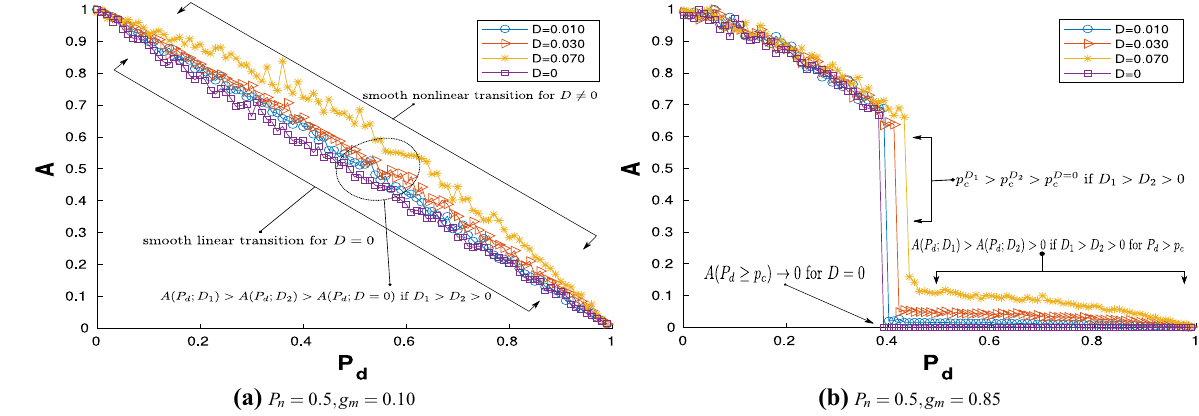
Figure 6. Variation of A with P d ; P n = 0.5 and D = 0.01, 0.03, 0.07 : ( a ) g m = 0.1 —smooth transition is observed; ( b ) g m = 0.85 —explosive AT is